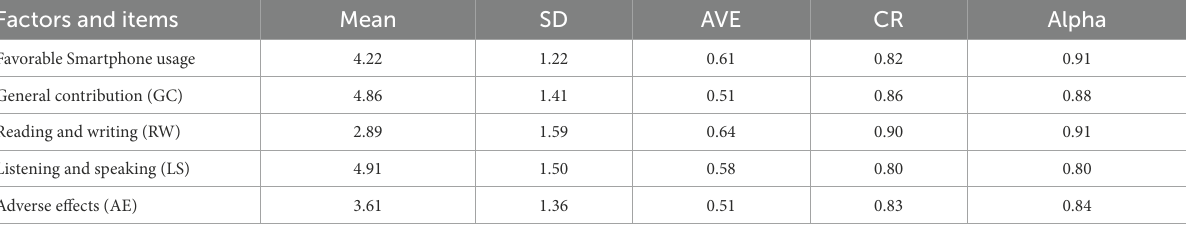
TABLE 2 The CFA of Smartphone use in learning foreign language scale (SULFLS; N = 502).